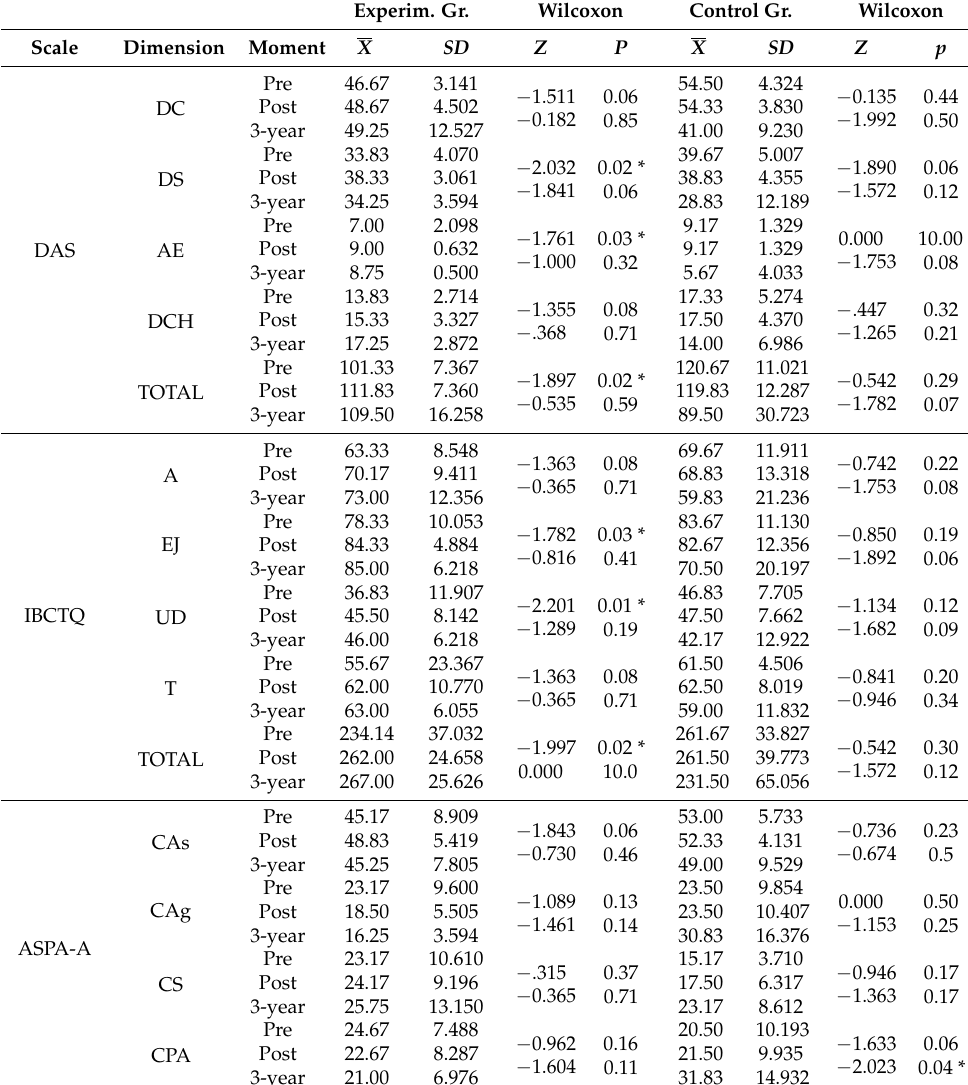
Table 3. Wilcoxon Z and associated probability ( p ) results pre–post and post-follow-up for experi- mental and control groups ( DAS , IBCTQ , and ASPA-A ). Experim. Gr. Control